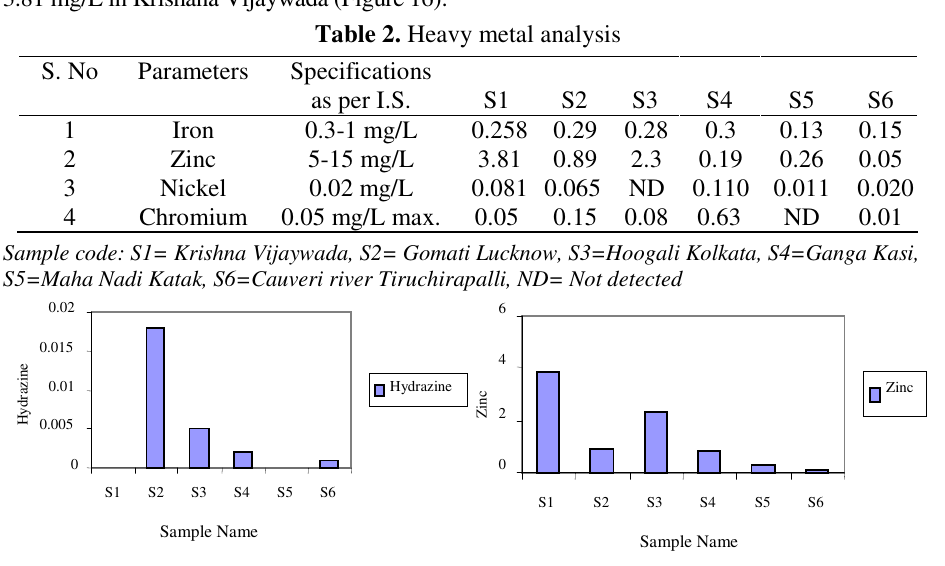
Figure 15. Hydrazine in various sample Figure 16. Zinc in various